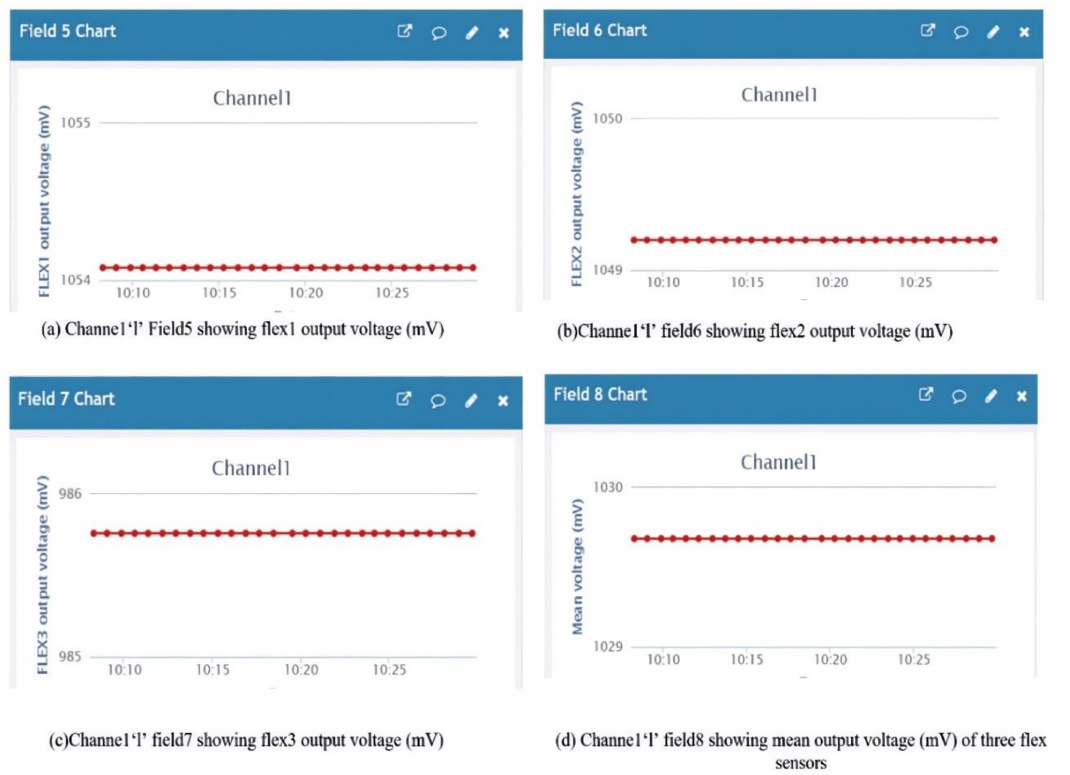
Figure 19. Channel ‘1’ showing the voltage output (mV) of all three flex sensors with mean level.